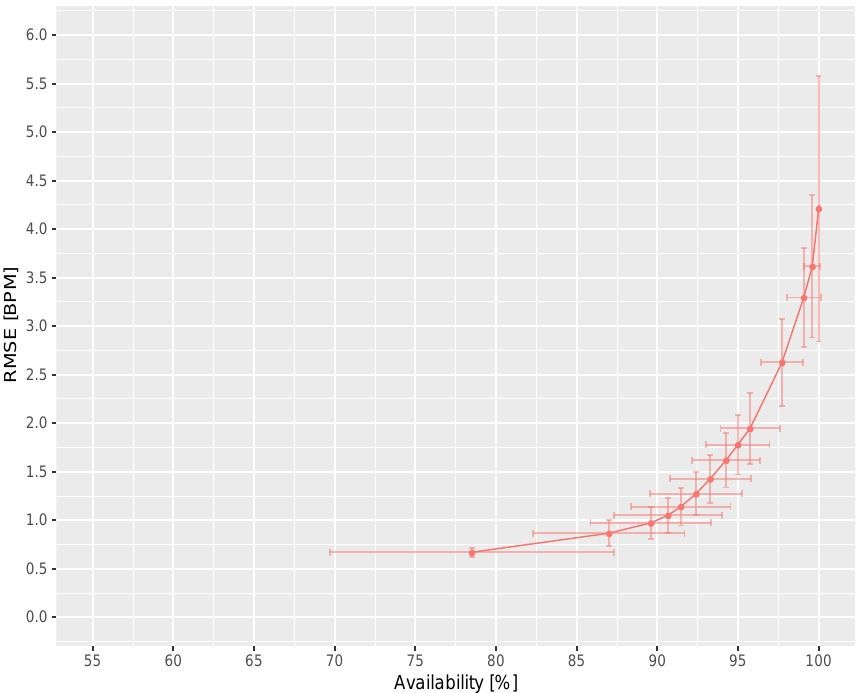
Figure 9. ROC curve of DIS in the benchmark dataset. The scatter denotes the RMSE at a specific availability. The horizontal and vertical bars denote the 95% confidence ranges of availability and RMSE, respectively.